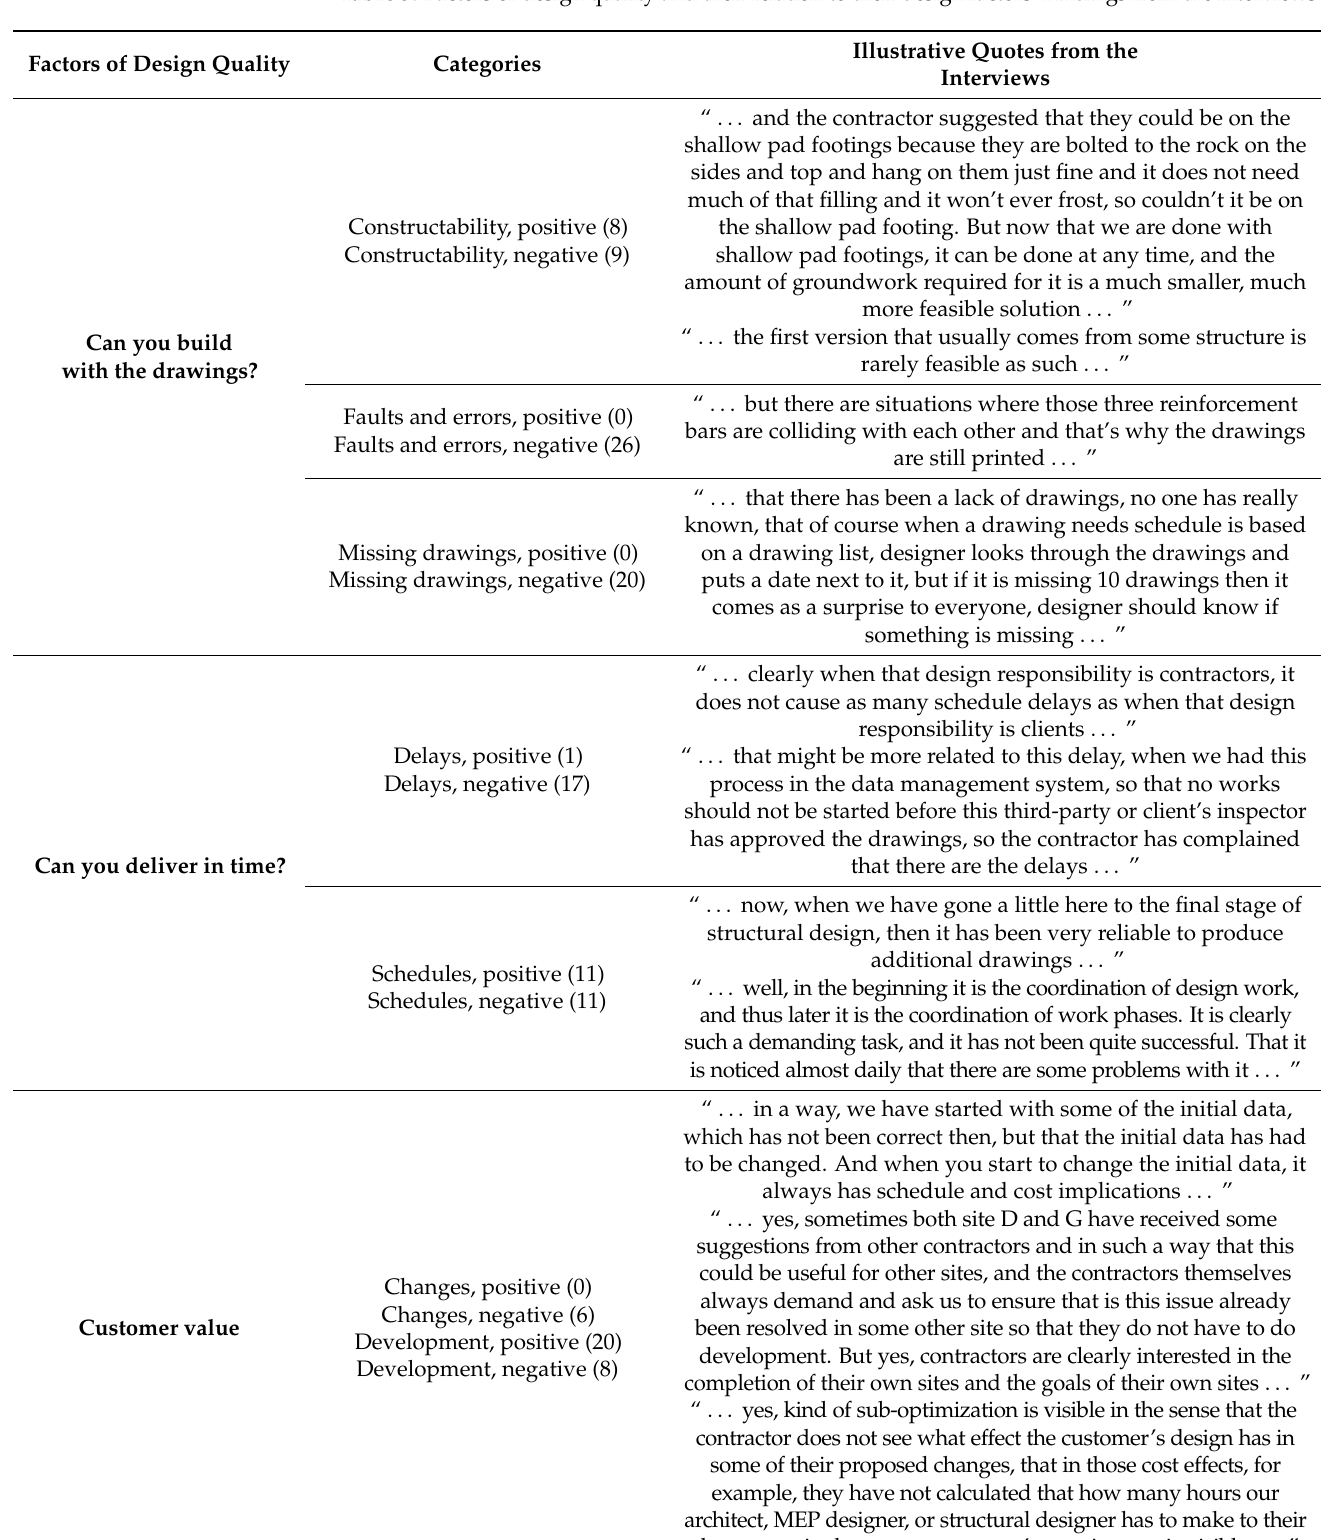
Table 3. Factors of design quality and their relation to their design factors. Findings from the